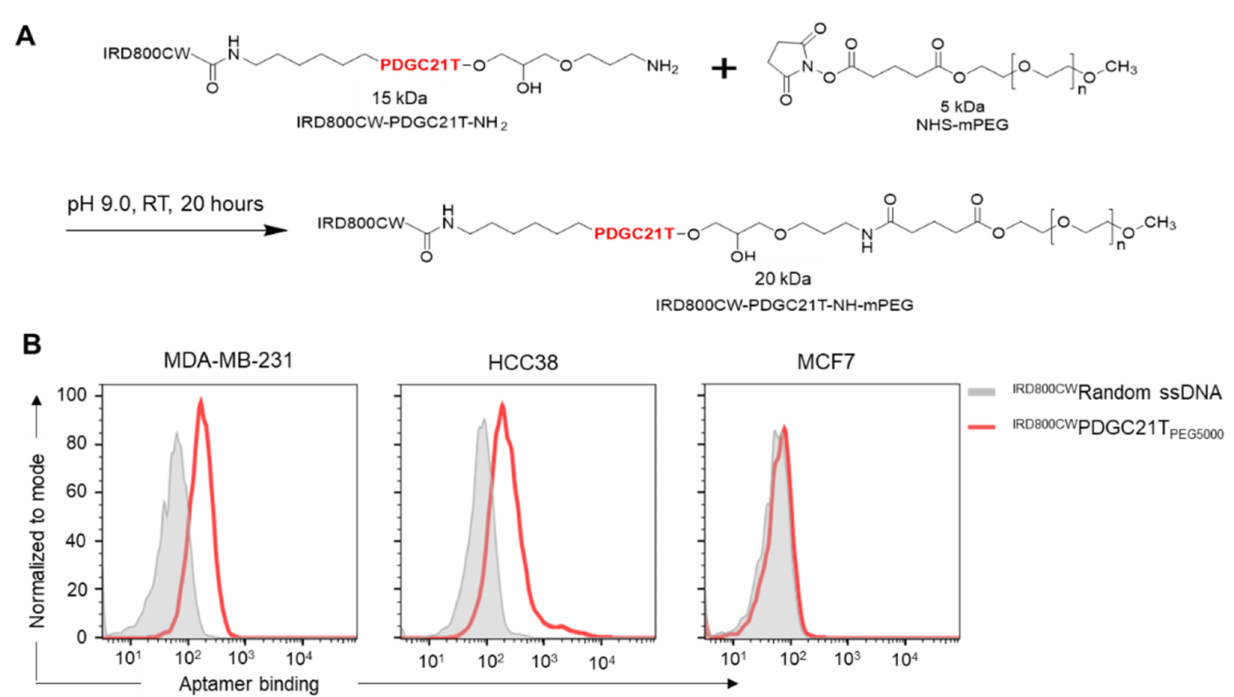
Figure 2. Preparation and validation of IRD800CW PDGC21T PEG5000 aptamers. ( A ) Schematic showing IRD800CW PDGC21T PEG5000 aptamer production. ( B ) Flow cytometry analysis